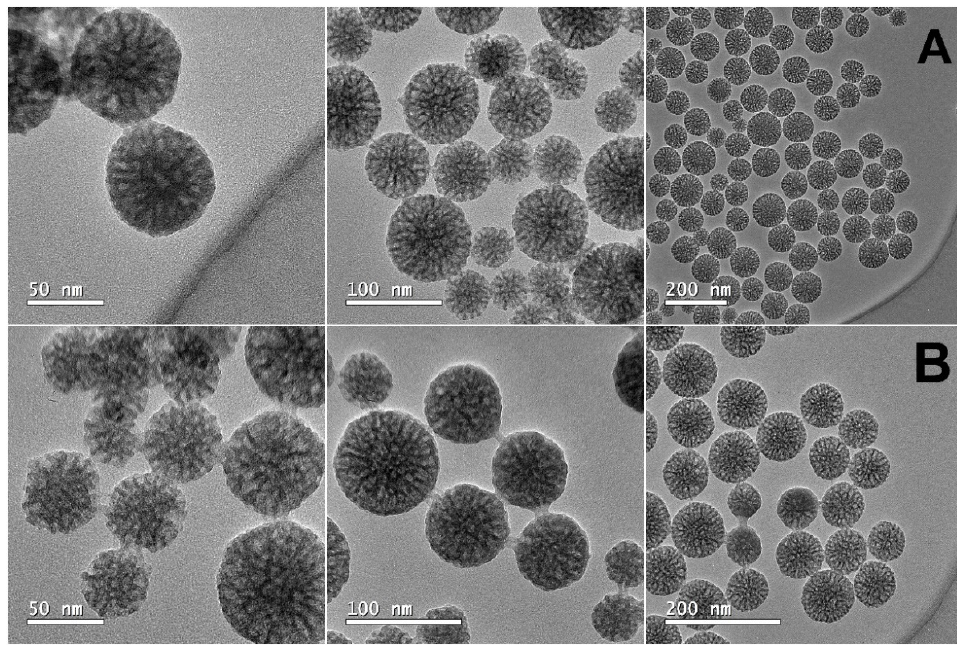
Figure 3. HR-TEM images of ( A ) MSNs and ( B )